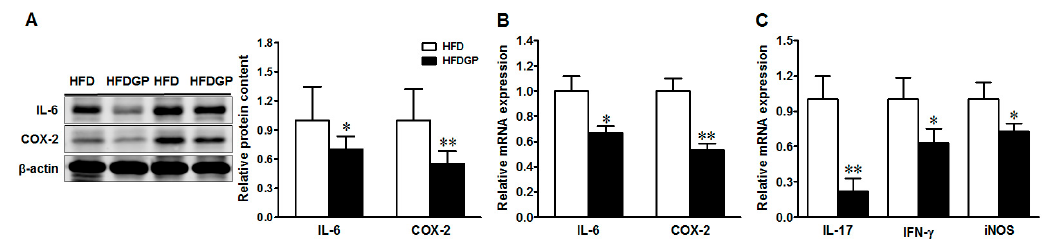
Figure 3. Inflammatory mediators in the colon of HFD or HFDGP fed DSS-colitis mice. ( A ) Representative immunoblotting bands and statistical data of IL-6 and COX-2; ( B ) mRNA expression of IL-6 and COX-2; ( C ) mRNA expression of IL-17, IFN- γ and iNOS. Means ± SEM, n = 7, * p ≤ 0.05, ** p ≤ 0.01.